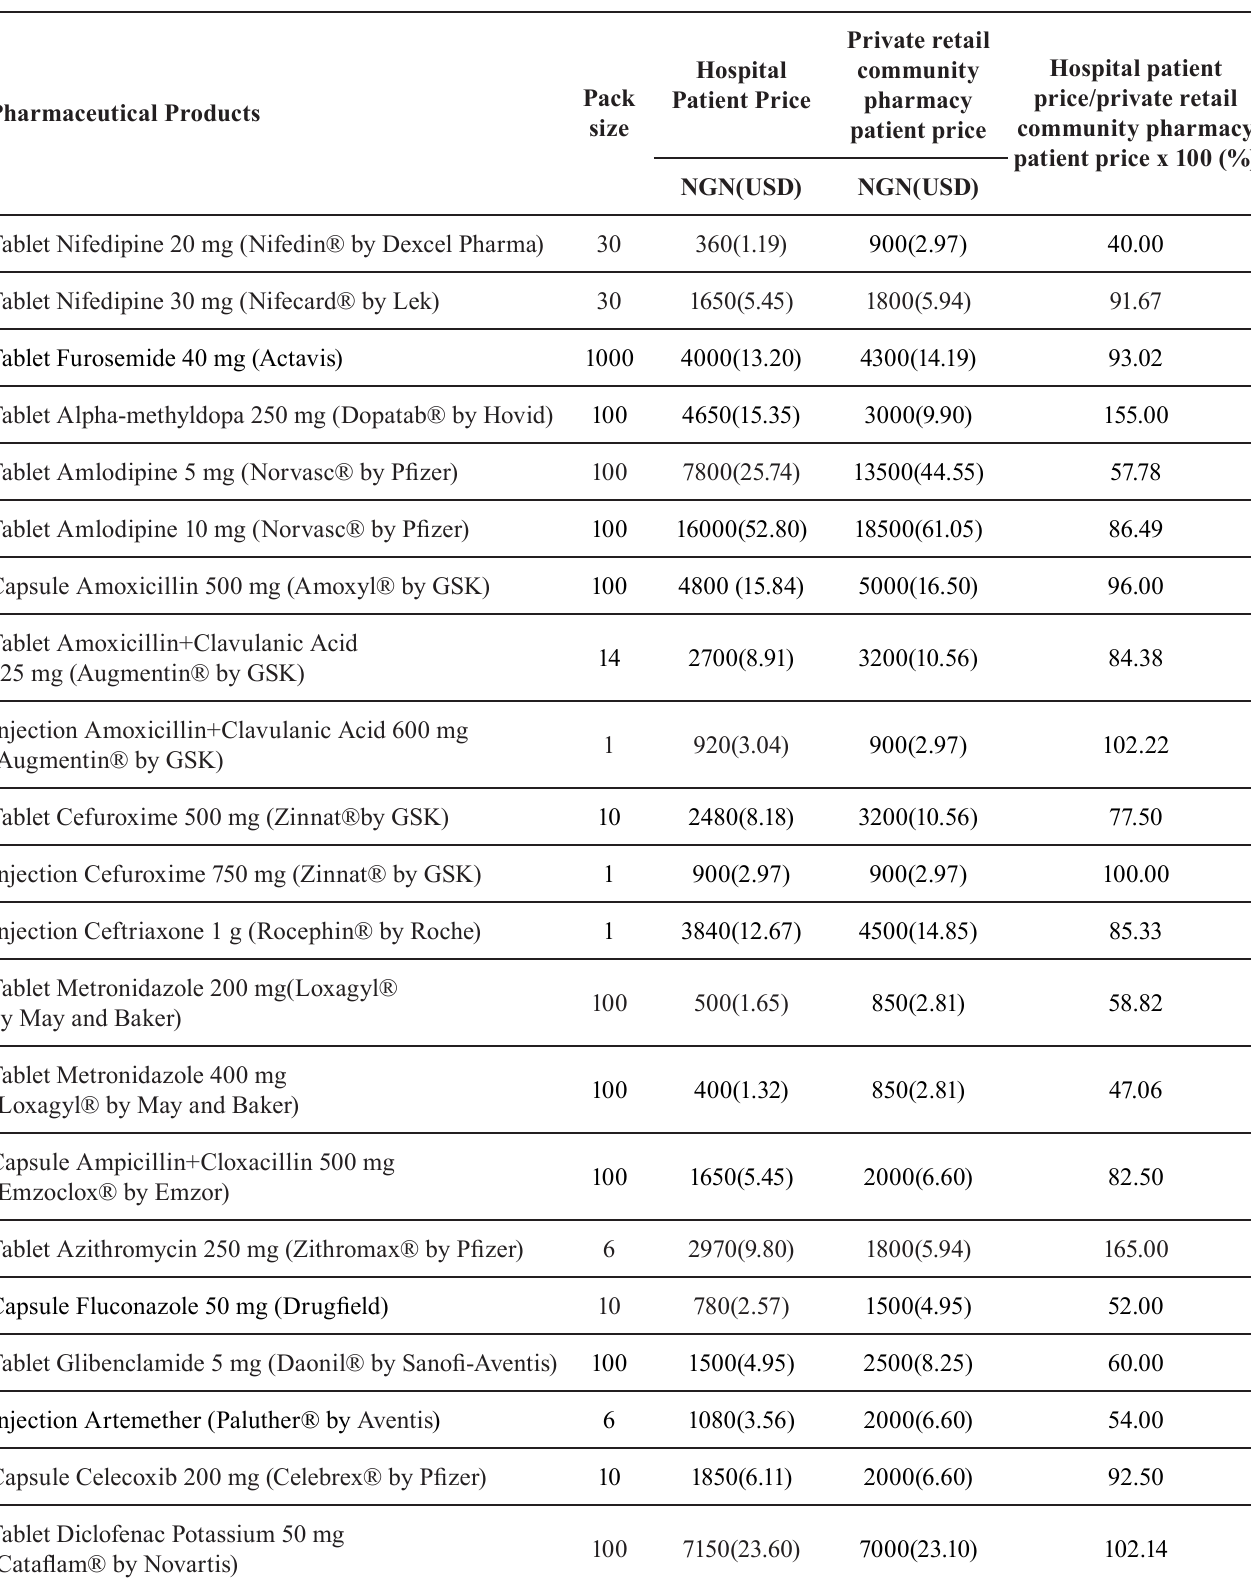
TABLE I – V ariability of the patient drug price of the same drug across studied hospital and private retail community pharmacy